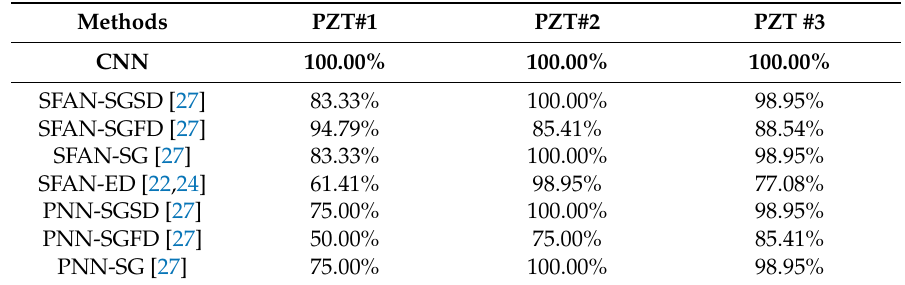
Table 3. Comparison of the CNN-based method with other NN approaches: Success rates obtained for the testing phase.